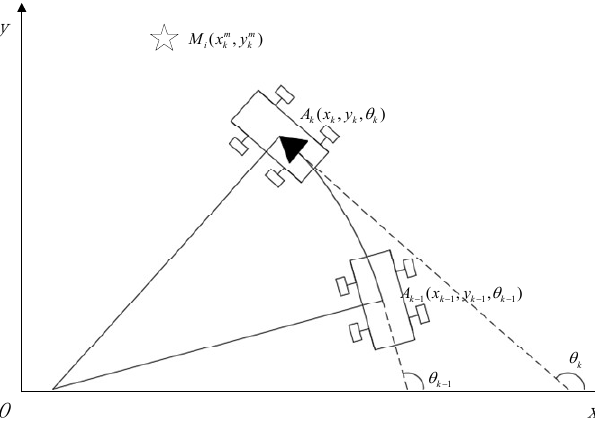
Figure 2. Observation model of mobile robot.